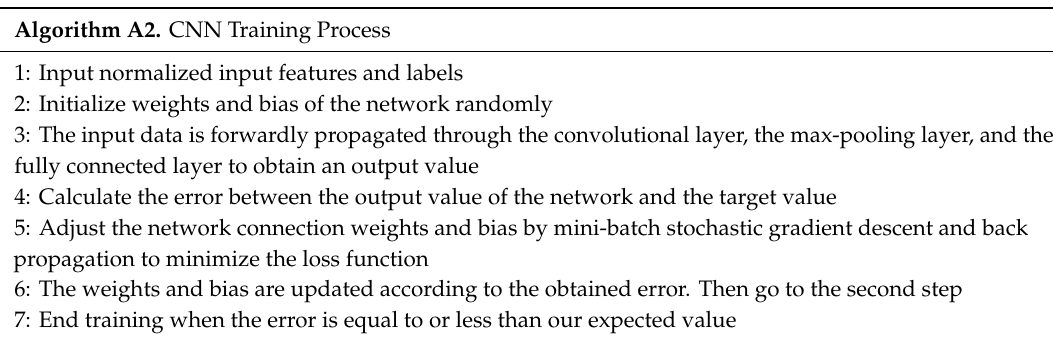
Algorithm A2. CNN Training